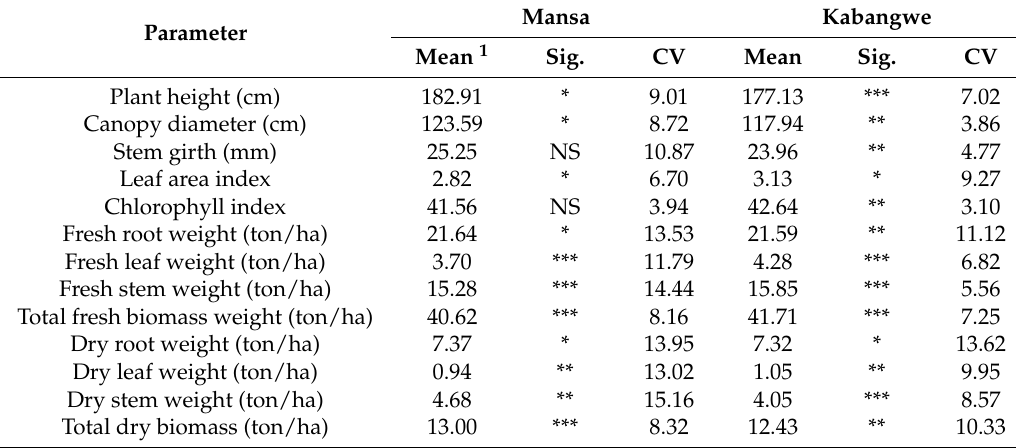
Table 3. Overall mean values of growth parameters and cassava yield as affected by fertilizer treatments in